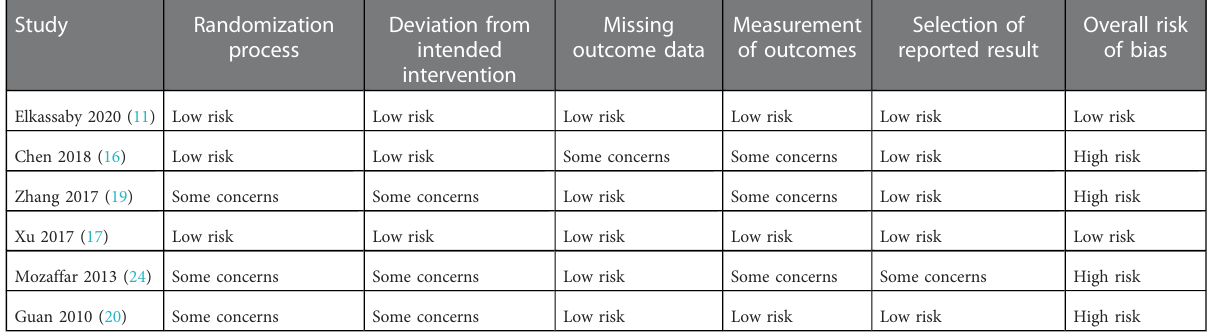
TABLE 4 Risk of bias analysis of RCTs.